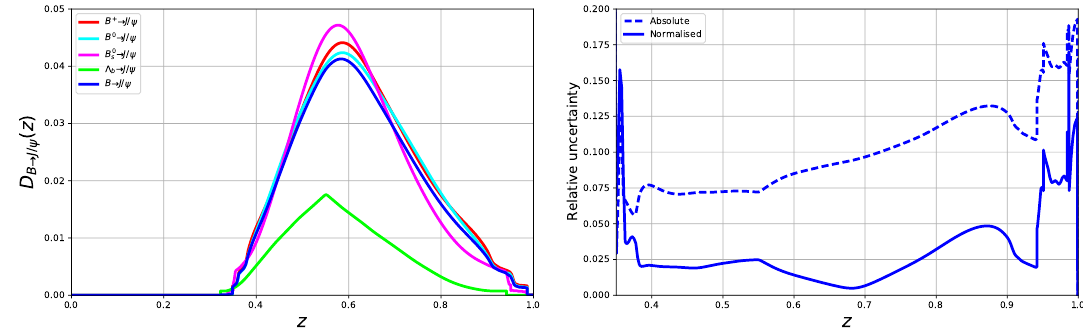
Figure 8 . The J/ψ decay fragmentation functions for various B decays (left) and corresponding uncertainty plot